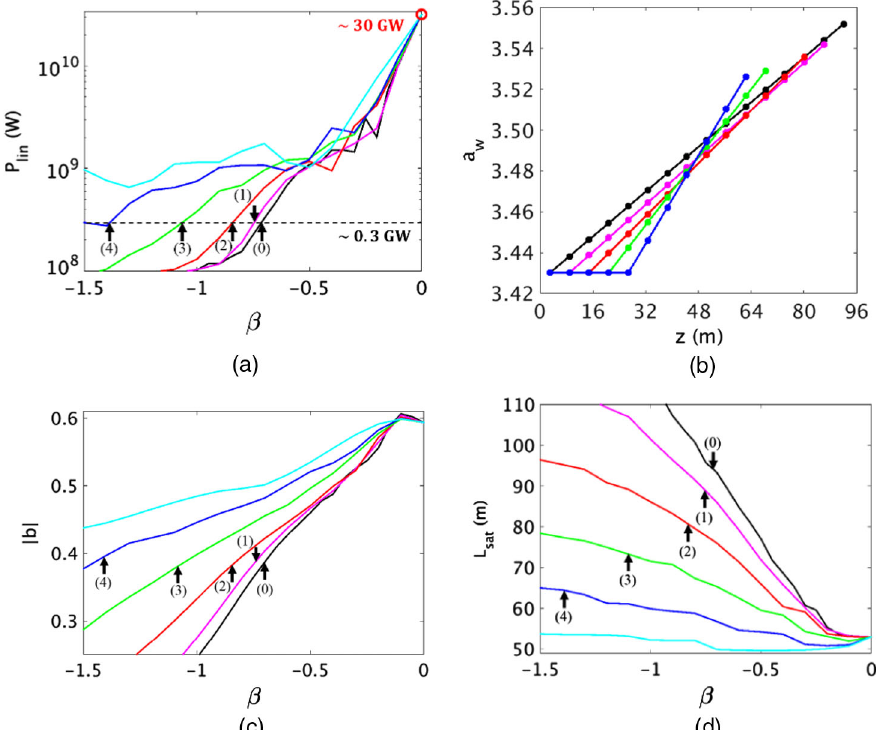
FIG. 3. Simulation results of the existing method (black lines) and modified reverse tapering method with 1 (magenta lines), 2 (red lines), 3 (green lines), 4 (blue lines), and 5 (cyan lines) untapered planar undulators: (a) Linearly polarized radiation power at the saturation point vs the taper strength. The dotted line denotes the target radiation power to be controlled. The black arrows with a number indicate the cross points between the solid lines and the dotted line to determine the taper strength for each case. (b) The rms undulator parameters along the planar undulator line for the five cases with the taper strength denoted by the arrows in (a). Note that the taper strengths are applied after the untapered undulators for each case. (c) Bunching factor at saturation point vs the taper strength. (d) Saturation length vs the taper strength. The black arrows in (c) and (d) indicate the same simulation points determined in (a).